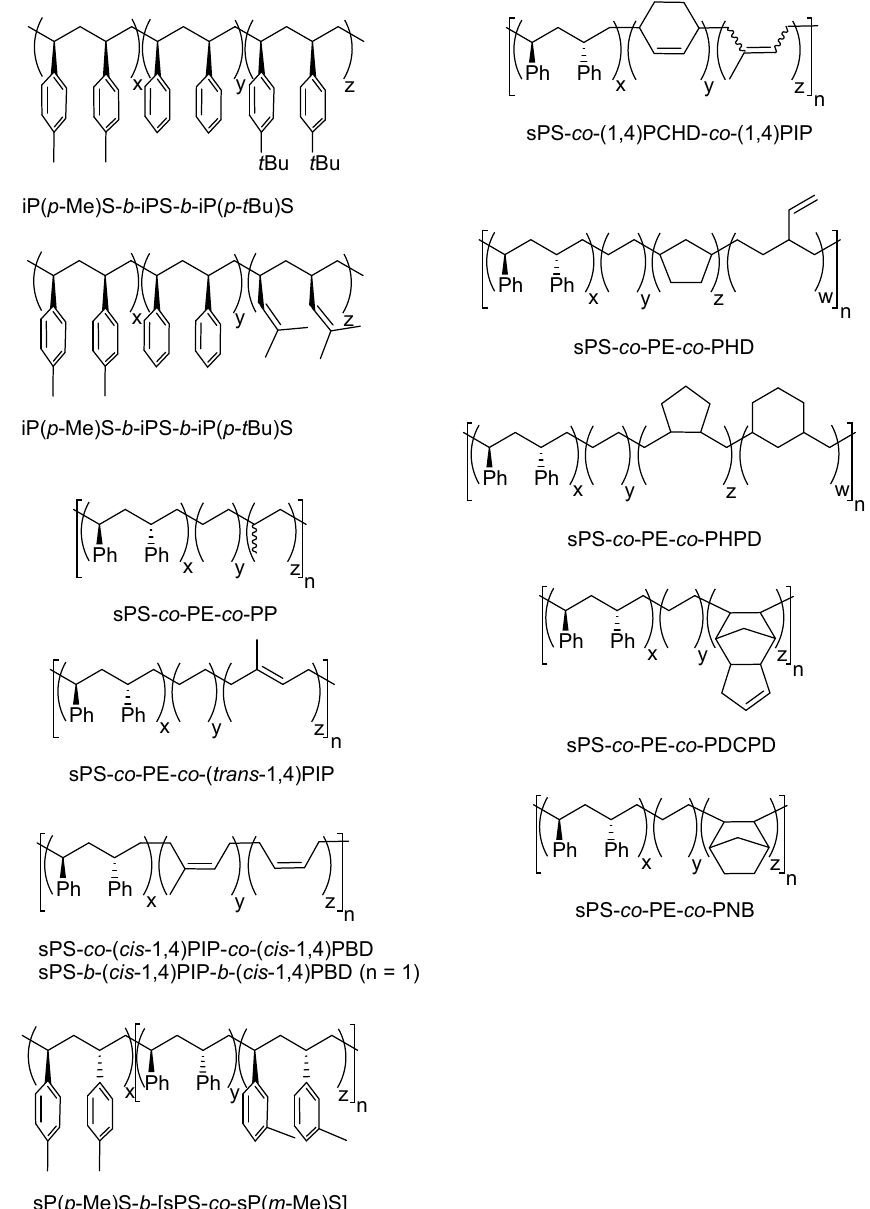
Figure 6. Structure of stereoregular styrene-based terpolymers.